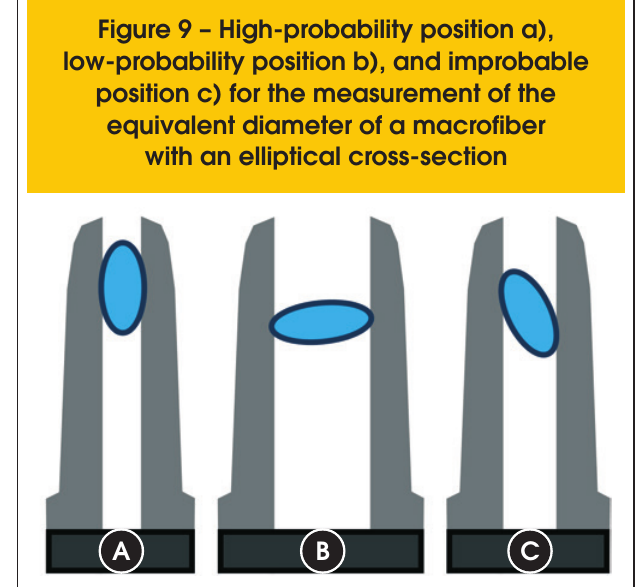
Figure 9 – High-probability position a), low-probability position b), and improbable position c) for the measurement of the equivalent diameter of a